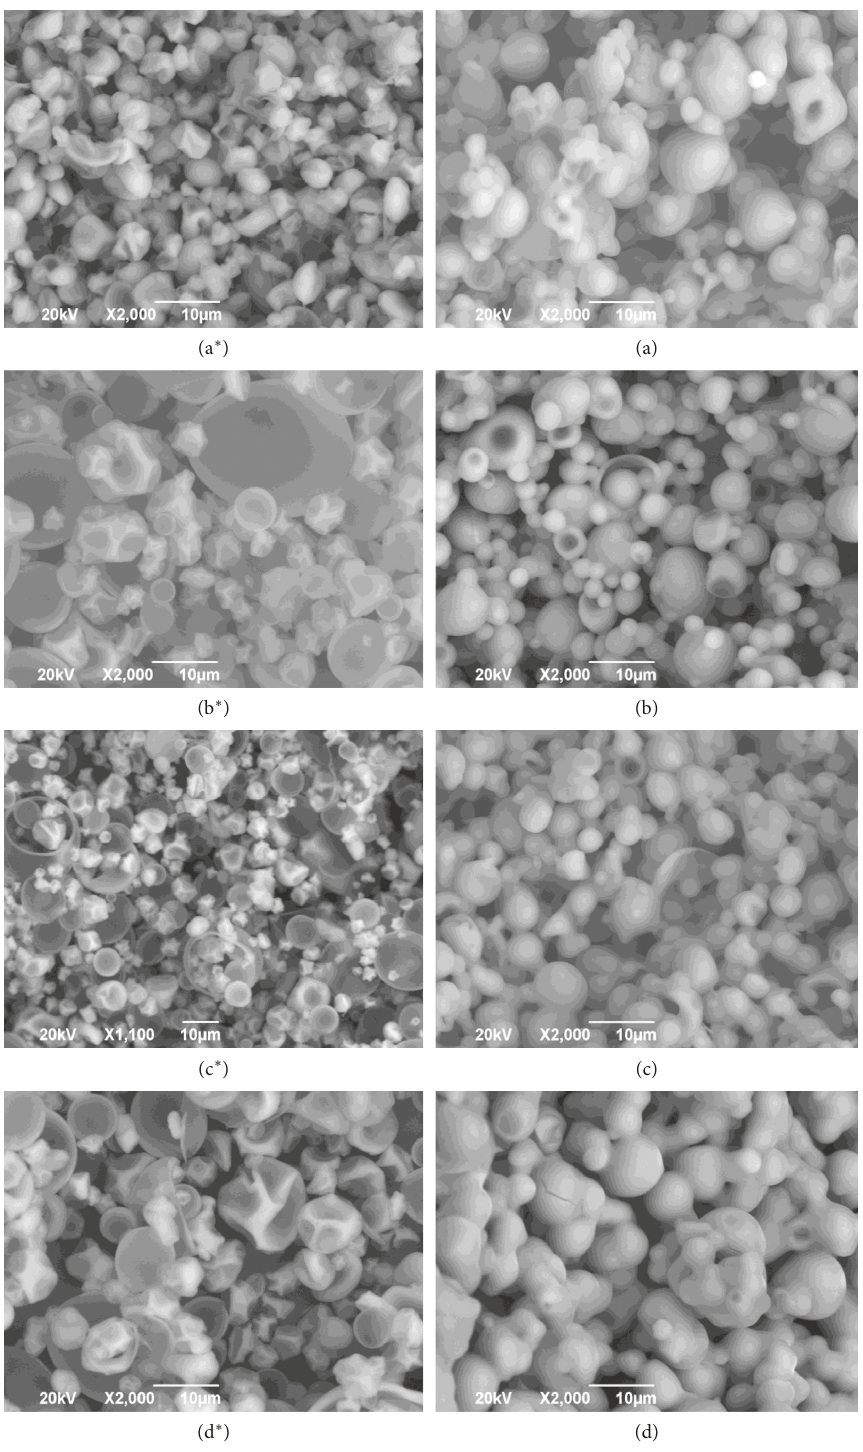
Figure 7: SEM images of Zn 2+ chlorophyllin microencapsules: (a–d) FOS powders. (a ∗ –d ∗ ) MD